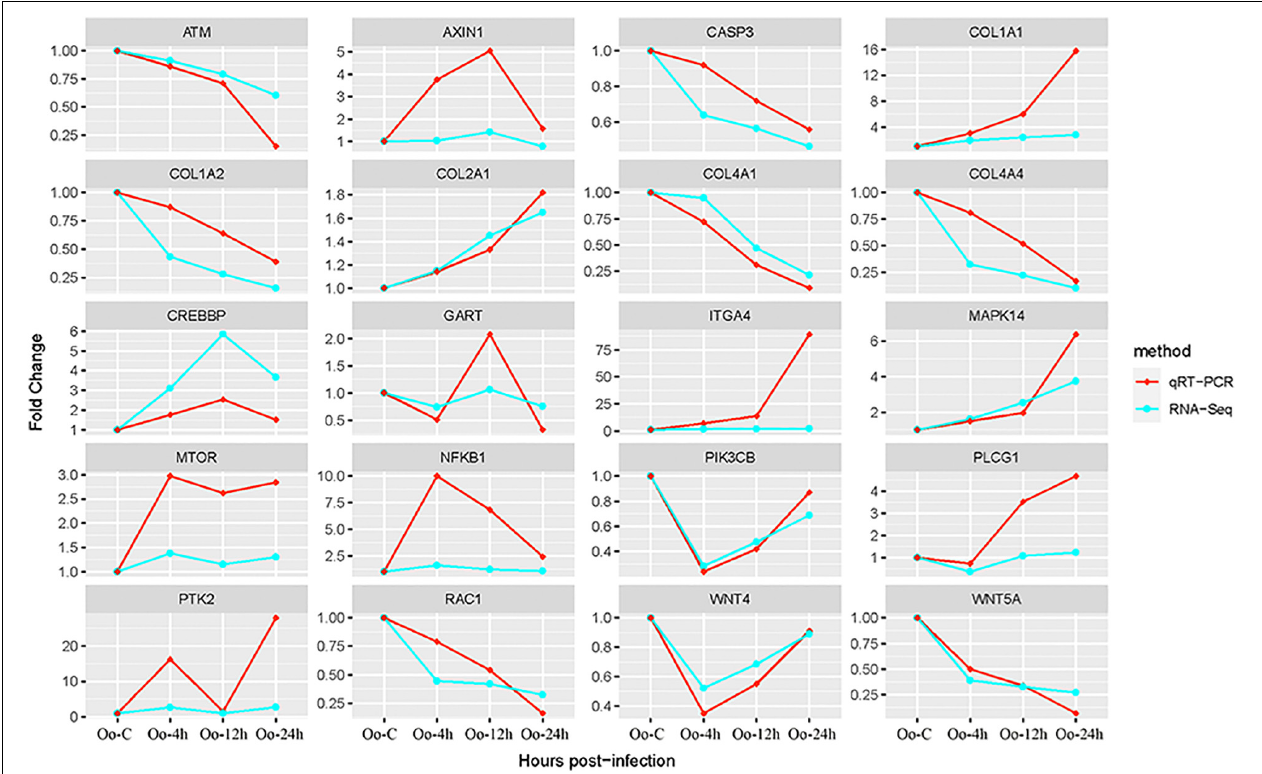
FIGURE 8 | Comparison of expression of 20 hub genes between qRT-PCR and RNA-Seq results. The transcript expression levels of the selected DEGs were each normalized to that of the β -actin gene. The x -axis represents the growth time after hatching; the y -axis stands for Fold